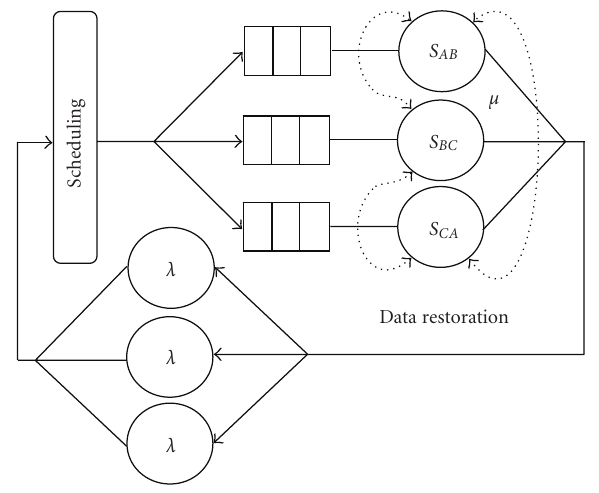
Figure 1: A queuing network representation of a partitioned database system with three